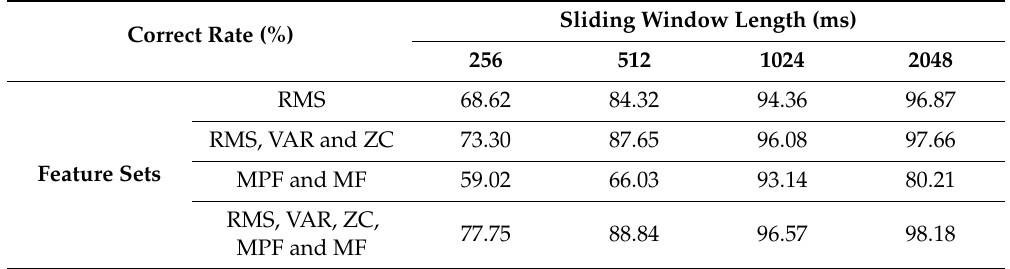
Table 5. Recognition accuracy of the LSTM model with di ff erent feature parameter sets and sliding window